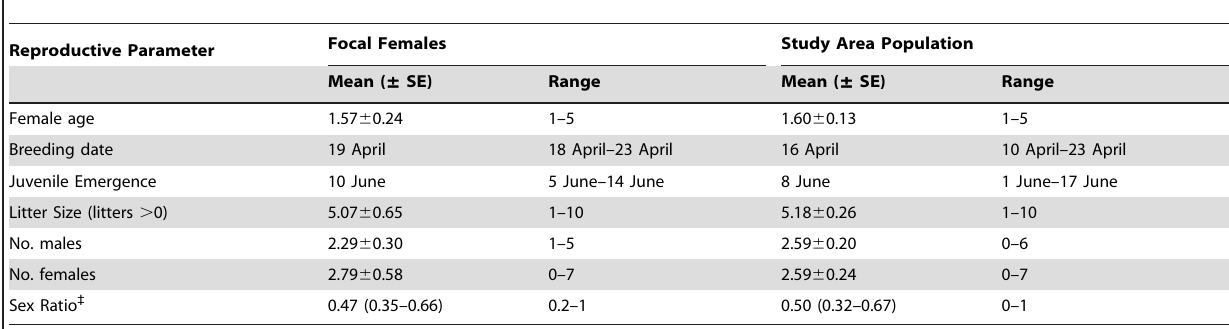
Table 2. Reproductive parameters for female Richardson’s ground squirrels during the 2013 breeding